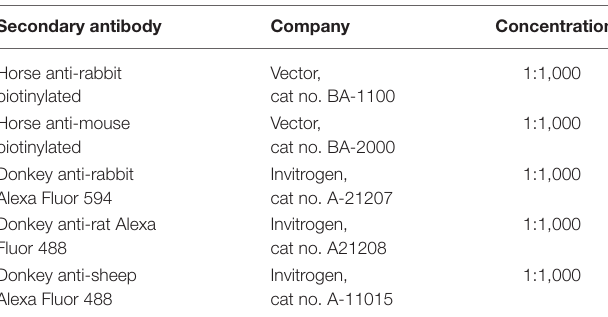
TABLE 2 | Secondary antibody information used when conducting nickel-enhanced 3,3-diaminobenzidine (DAB) and fluorescent-labeling